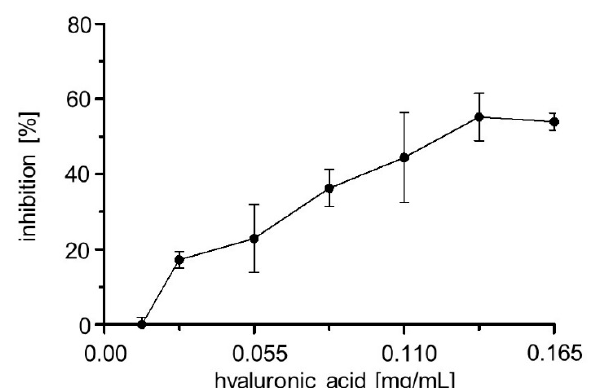
Figure 11. Inhibition of Hyal1 by 250 µM glycyrrhizic acid, in dependency on HMW HA concentration. E. coli F470 cells expressing Hyal1 were harvested after 16 h of induction and the OD 578 was set to 10 adding reaction buffer (sodium formate pH 3.5, 0 mM NaCl). Glycyrrhizic acid was added [250 µM final) and cells were preincubated for 10 min. After adding 0.22mg/mL HMW HA, a (1:1 v/v) reaction was performed at 37 °C for one minute. Inhibition of Hyal1 was calculated in accordance to our previous studies. Mean values ± SD (n = 3).